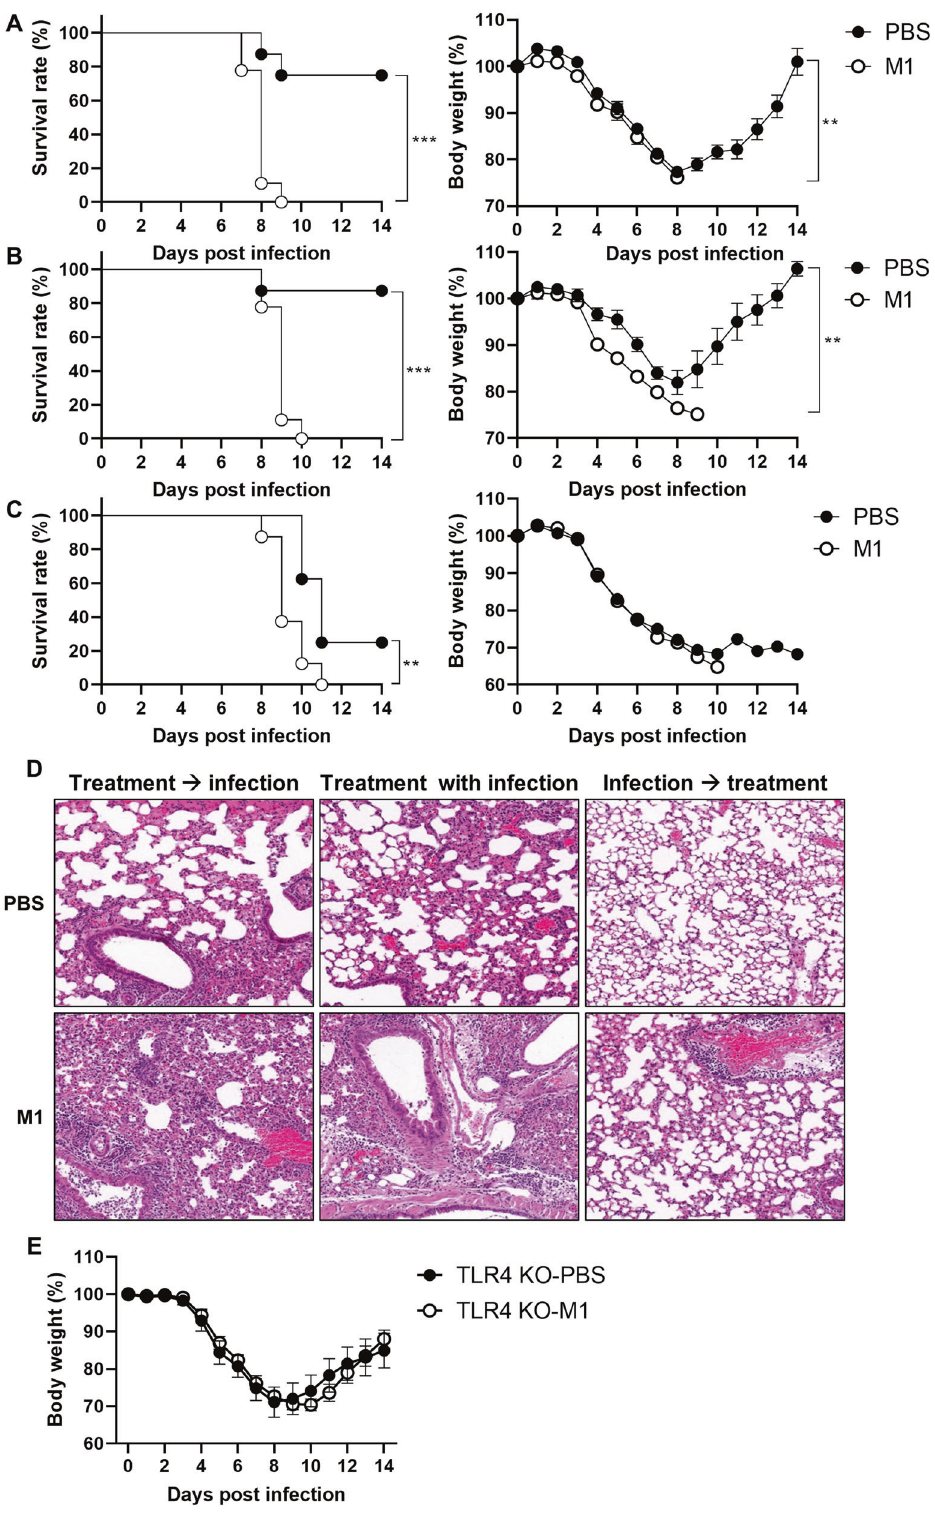
Fig. 6 M1 aggravates in fl uenza pathogenesis in a TLR4-dependent manner. Mice were intranasally treated with rM1 (30 μ g) 3 days prior to ( A and left panel of D ) or simultaneously with ( B and middle panel of D ) or 3 days after ( C and right panel of D ) PR8 in fl uenza infection. A – C Survival rates and body weight change were monitored for 2 weeks ( n = 8 ). D Lung tissues obtained on day 5 post infection were visualized using H&E staining ( n = 2 ). E TLR4 − / − mice were treated intranasally with rM1 (30 μ g) and co-infected with PR8 in fl uenza virus (32 PFU), and the body weight change was monitored for 2 weeks ( n = 8 ). *** p < 0.001, ** p < 0.01, * p < 0.05 in the log-rank test.